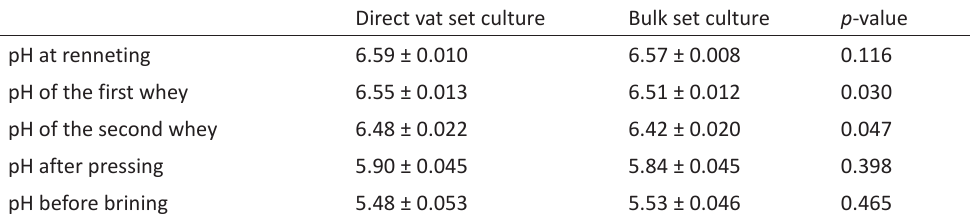
Table 2. Mean pH values during processing (± standard error) and statistical significance of difference between direct vat and bulk set culture according to the pairwise t-test.